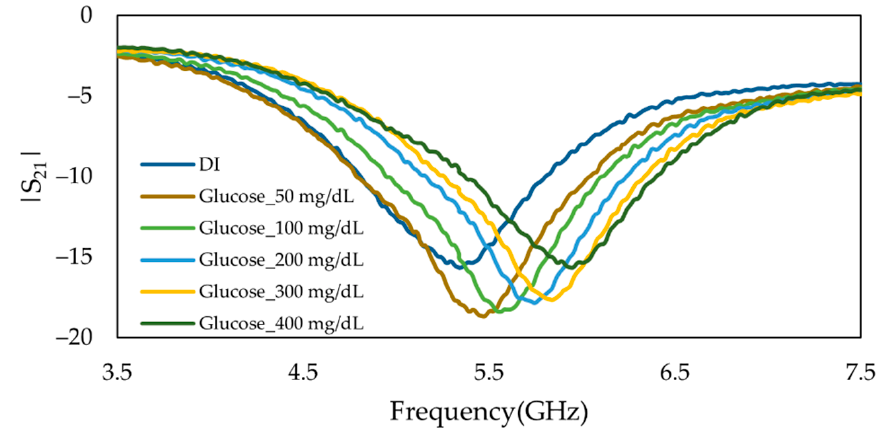
Figure 11. Measured frequency response of the insertion loss (S21) of duplicate MIP-coated microwave-based stub biosensor for the glucose solutions with concentration ranging from 50 mg/dL to 400 mg/dL.